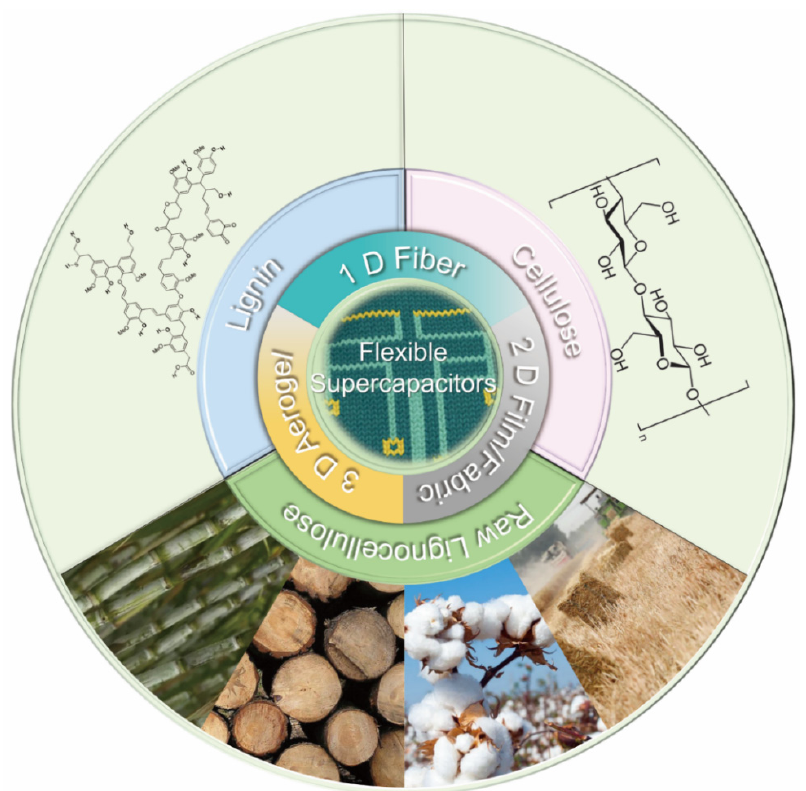
Figure 1. Overview diagram of lignocellulosic biomass-derived carbon electrodes for flexible supercapacitors (reproduced with permission from ref. [31] Copyright 2014 John Wiley and Sons) in this review.